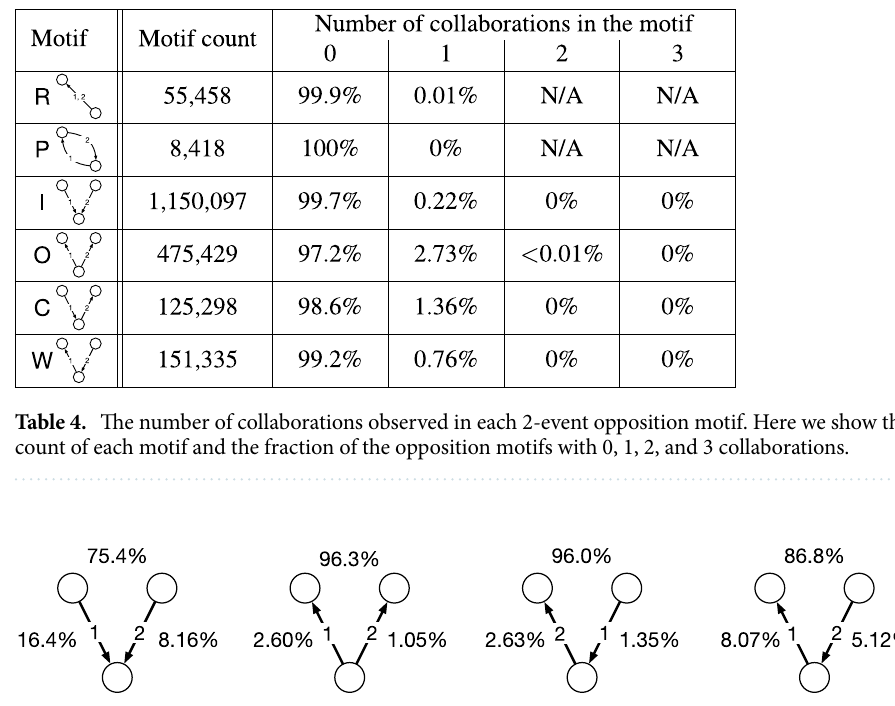
motifs. The scarcity of multiple collaborations is also observed in the 3-event opposition motifs; more than 91% of them do not have any collaborations (see Supplementary Table 2). Companies involved in the collaborations. Patent opposition and collaboration are not exclusive actions. They may occur between the same pair of companies because they may collaborate in one field and compete in another field for strategic reasons. To examine this possibility, we investigate which two companies that belong to the same motif are more likely to collaborate with each other. We exclude the 2-node opposition motifs (i.e., repetition and ping-pong) from the following analysis because 2-node motifs only involve two companies such that which pair of companies in the motif tends to collaborate is an irrelevant question. Figure 7 shows the fractions of collaborations between each pair of companies in each type of 3-node 2-event opposition motif with at least one collaboration. We find that collaborations tend to occur between the companies that have no opposition relation with each other. For example, in out-burst motifs, 96.3% of the collaborations occur between the two nodes that have no opposition relationship. In other words, two companies opposed by